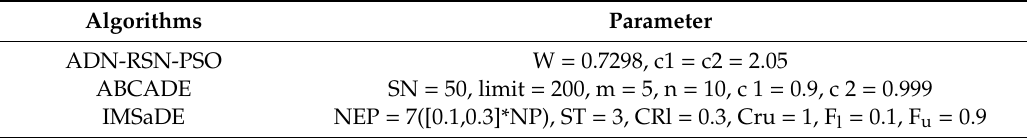
Table 2. Arithmetic parameter